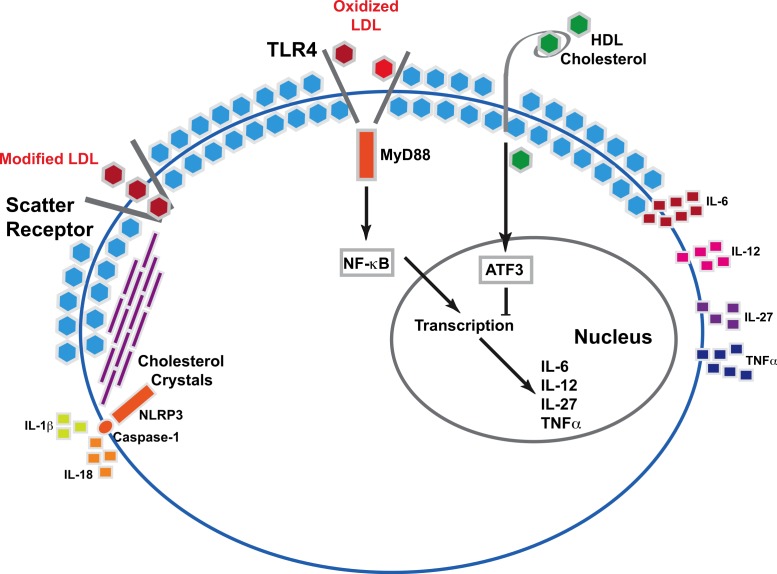
Molecular mechanism underlying cholesterol stimulated cytokine release.Modified LDL cholesterol is absorbed into cells via scatter receptors. At high intracellular concentrations of cholesterol, crystals form. In combination with inflammatory stimuli such as lipopolysaccharide, cholesterol crystals activate NLRP3 inflammasome-caspase-1 activity, leading to the release of mature IL-1b and IL-18. The Toll-like family receptors recognize oxidized LDL. Binding of oxidized LDL cholesterol activates inflammatory signaling via MyD88 and NFκB. This results in increased transcription of the inflammatory cytokines IL-6, IL-12, IL-27 and TNFα. HDL cholesterol alters the activity of ATF3 to suppress TLR activated transcription of inflammatory cytokines.